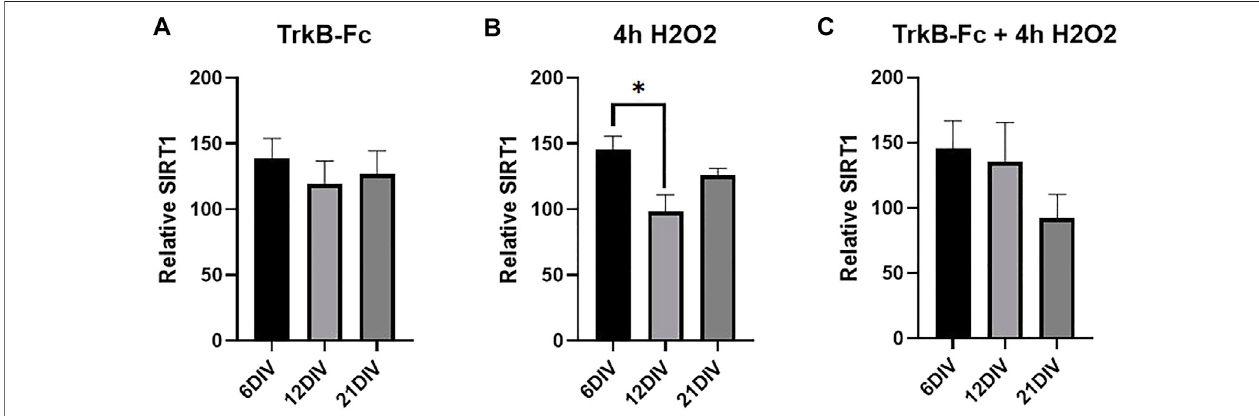
FIGURE 4 | SIRT1 is Elevated in 6 DIV Neurons Treated with Hydrogen Peroxide. (A) SIRT1 western blot analysis of hippocampal neurons treated with 1 μ g/ml TrkB-Fc for 24 h. Welch ’ s ANOVA, p = 0.72. (B) SIRT1 western blot analysis of hippocampal neurons treated with 200 μ M H2O2 for 4 h. Welch ’ s ANOVA * p =